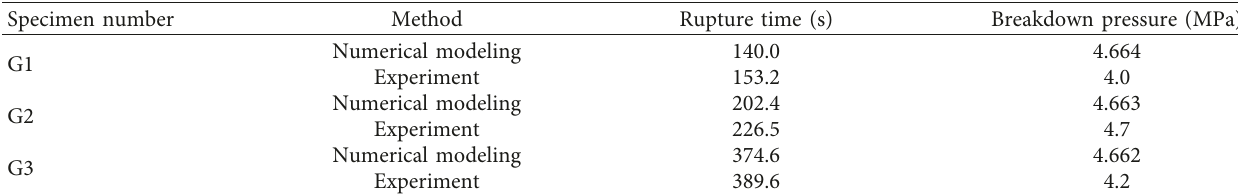
Table 6: The numerical and experimental values of rupture time and breakdown pressure (nitrogen gas